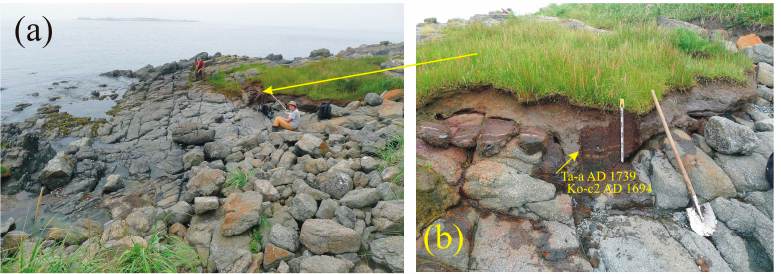
Figure 10. ( a ) Peat bog of the LIA (site 43 on Figure 2) on an uplifted bench of Tanfiliev Island, Lesser Kuril Ridge; ( b ) peat bog section with marker tephra layers Ta-a (1739 CE) and Ko-c2 (1694 CE) from the eruption of Tarumai and Komagatake volcanoes, located on Hokkaido